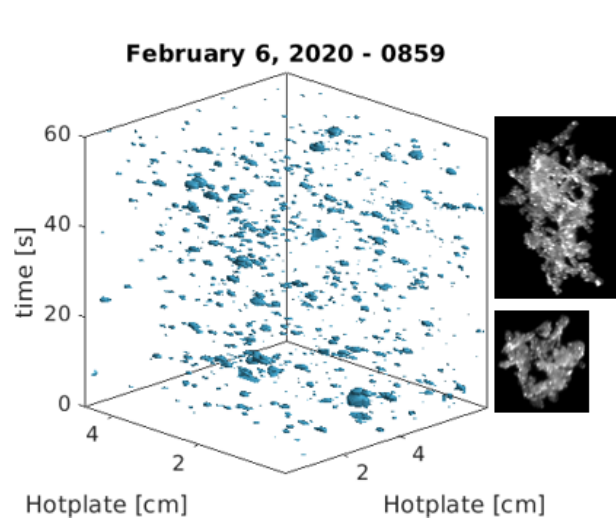
Figure B2. As for Fig. B1 but for partly melted